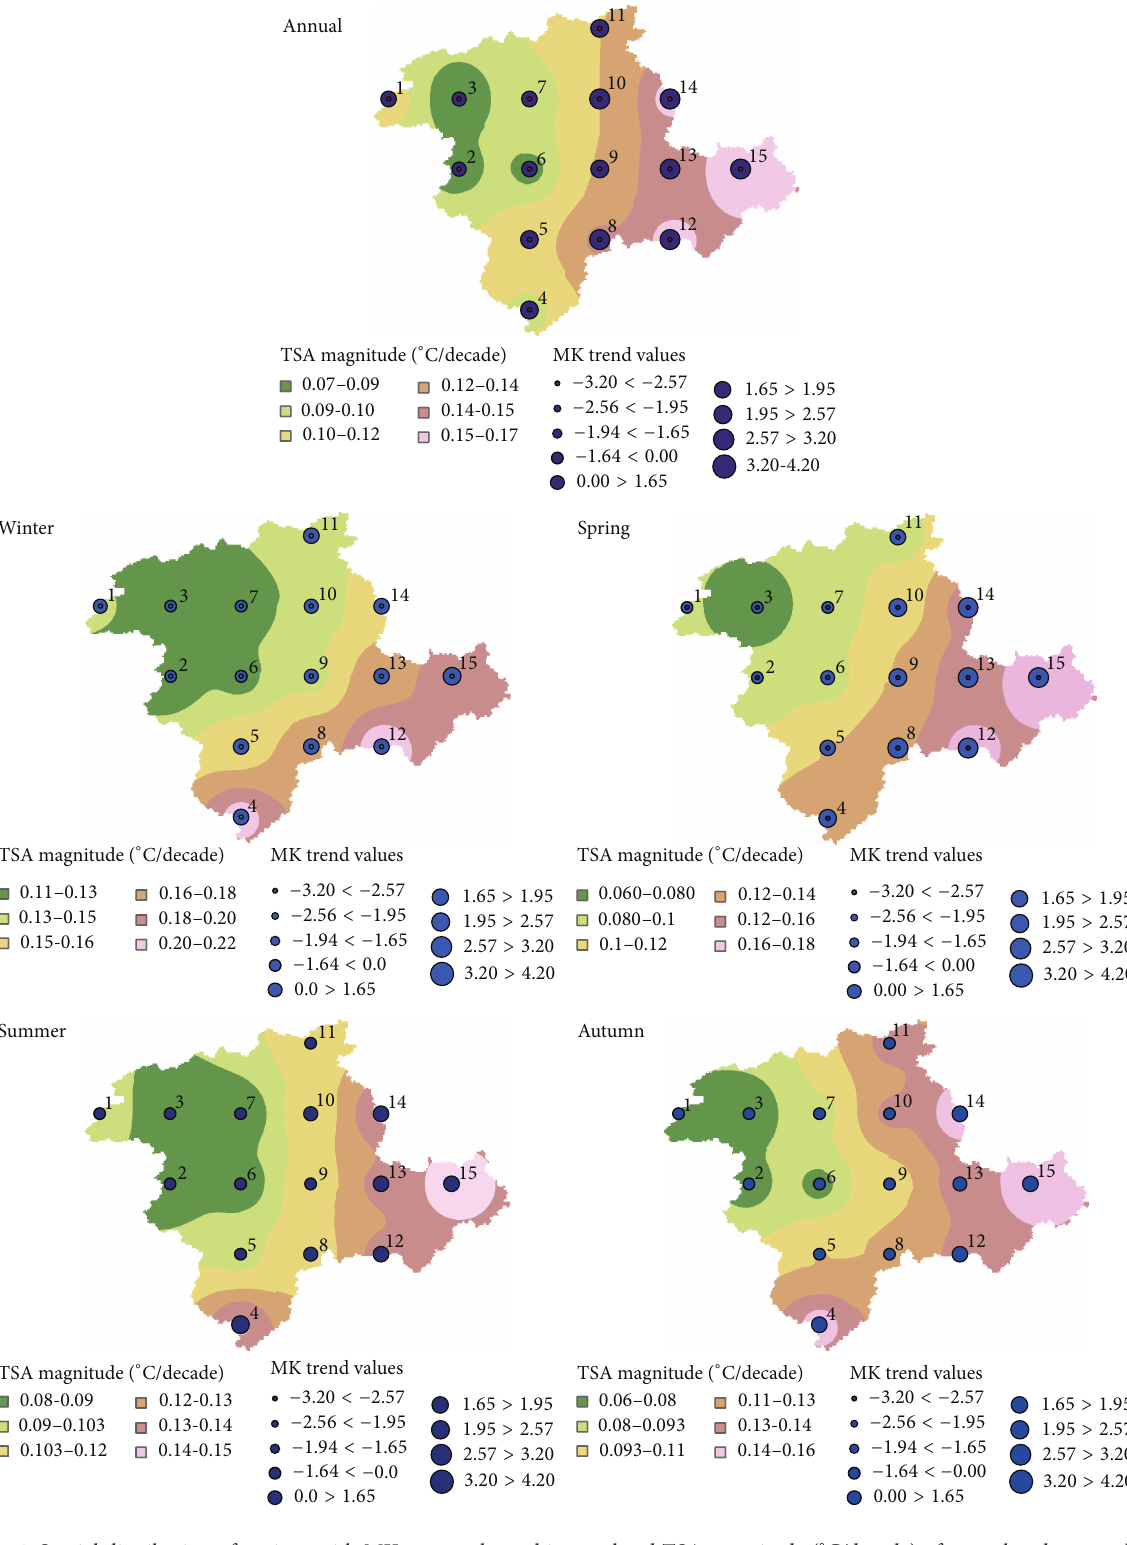
Figure 4: Spatial distribution of stations with MK test results and interpolated TSA magnitude ( ∘ C/decade) of annual and seasonal TMin data series over the period of